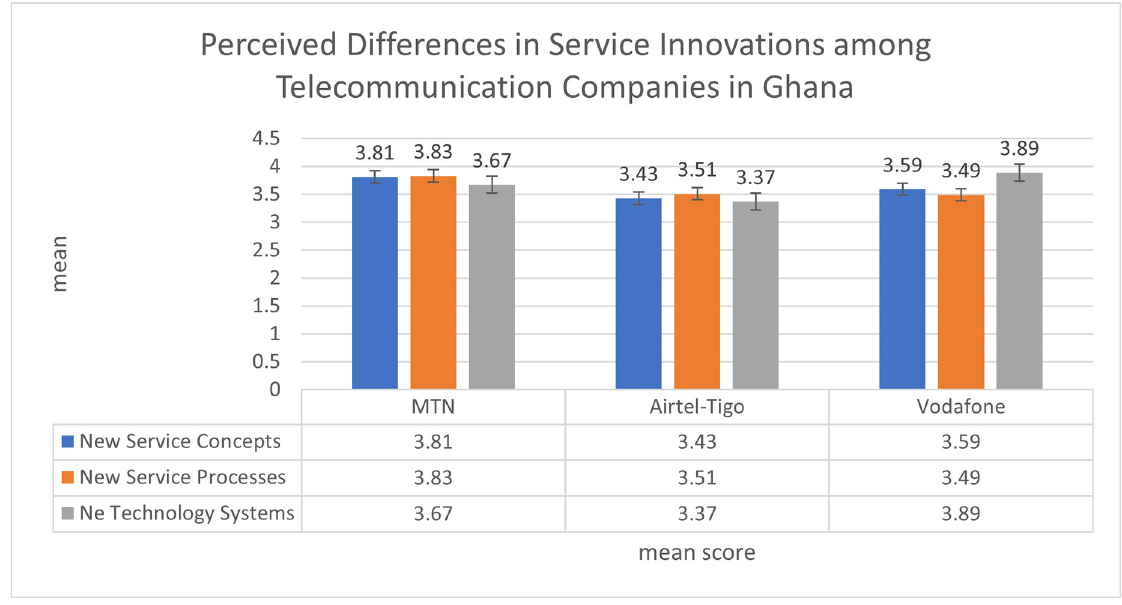
Fig 1. Perceived differences in service innovation among telecommunication companies in Ghana. Source: Field Survey (2021).